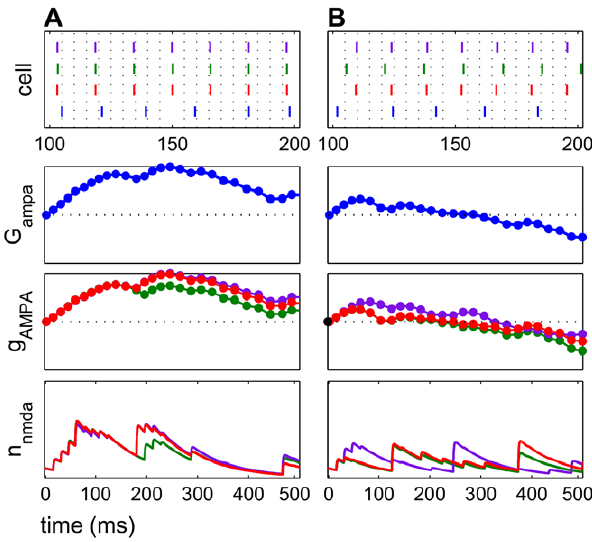
Figure 7. Potentiation increases monotonically with constant NMDAR currents with no decay. The top panel in each subfigure shows a raster plot, with input spikes (red) and E cell spikes (blue), enlarged over the first 250 ms to show detail. Second panels are AMPAR conductance over time. Third panels are AMPAR current open probabilities n ampa . Bottom panels are NMDAR current open probabil- ities n nmda . (A) A potentiating frequency regime ( f I =67 Hz, f N =45 Hz) is shown with t nmda of 80 ms in which potentiation lasts only for a short time before becoming depression. (B) In this potentiating frequency regime ( f I =77 Hz, f N =36 Hz) with a constant, non-decaying NMDAR current, potentiation increases monotonically. Glutamatergic events occurred on every cycle, since the spiking of the E cell was not being influenced by a slowly decaying NMDAR current. The regime used in (A) showed depression if the NMDAR current did not decay.